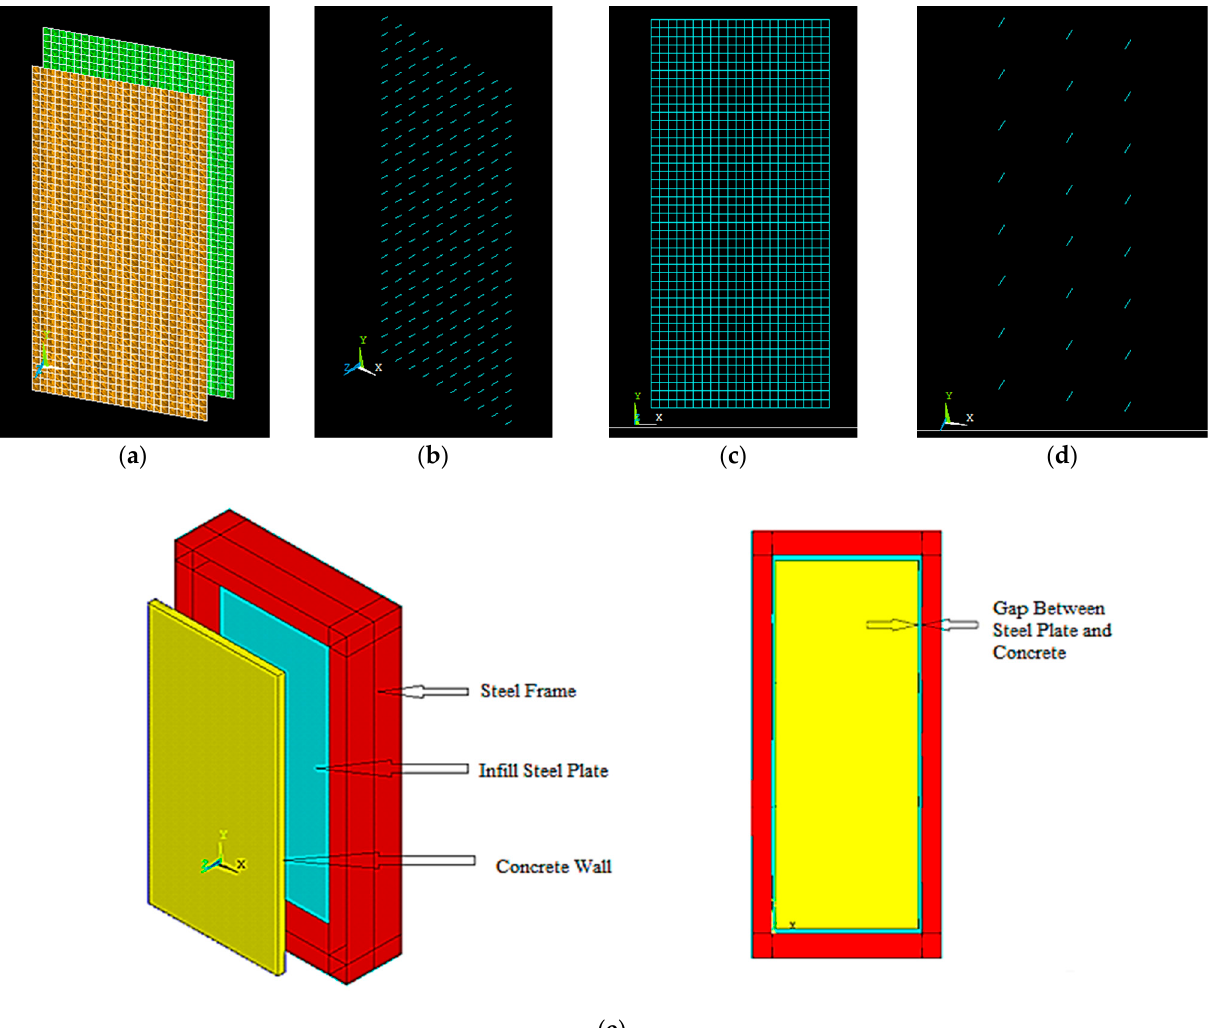
Figure 4. Contact between different elements: ( a ) interface surface; ( b ) load slip; ( c ) reinforcement; ( d ) shear stud; ( e ) assembled FEM.